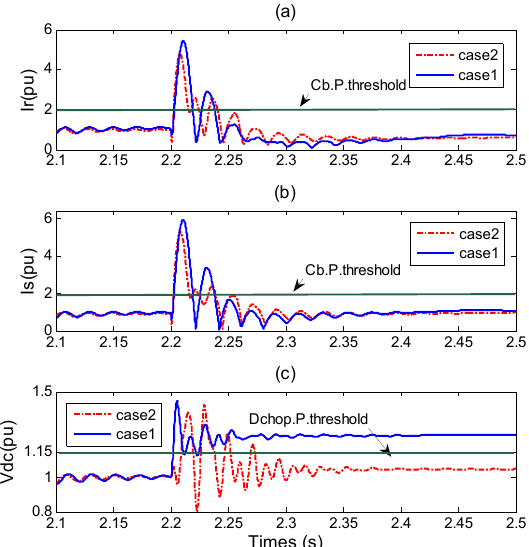
Figure 12. The responses of the DFIG WTG for case 2. ( a ) rotor current; ( b ) stator current; ( c ) DC voltage.